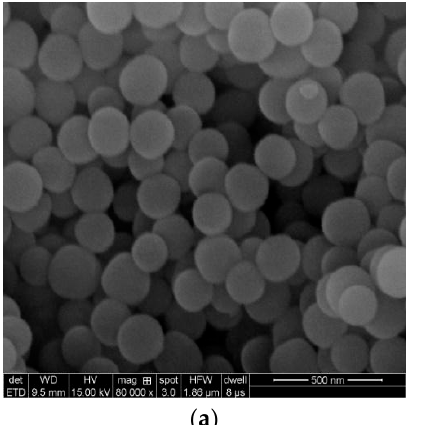
Figure 3. SEM images of the ( a ) RBS-doped silica microspheres, and ( b ) dual-emission silica microspheres.